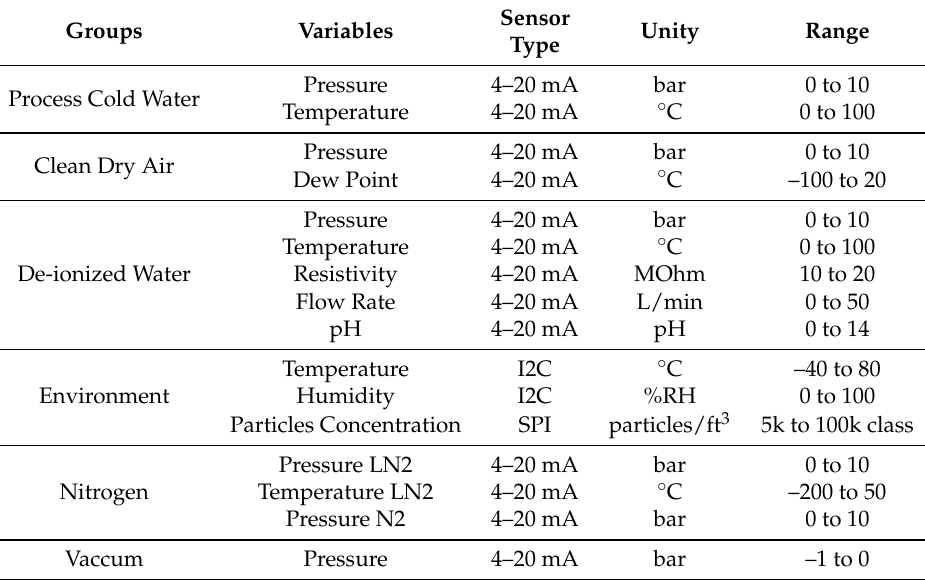
Table 1. Example of process variable groups and sensors